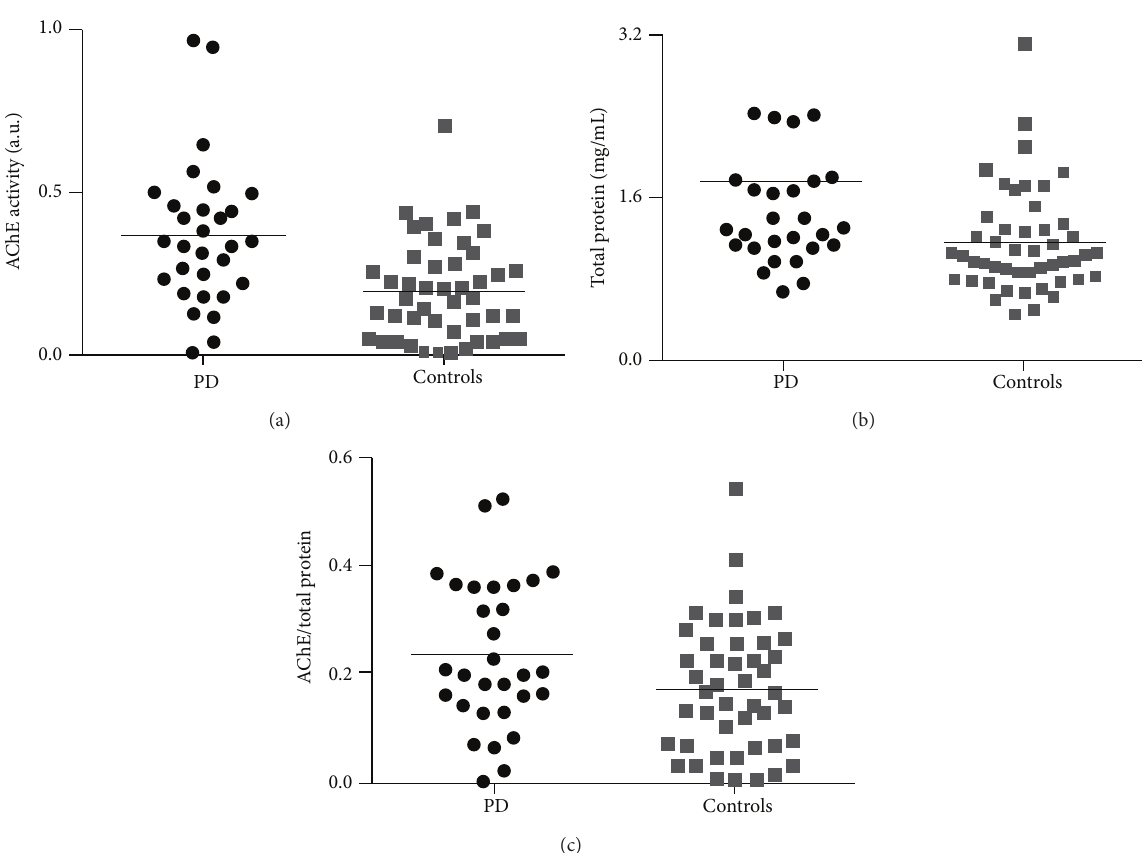
Figure 2: Salivary AChE activity (a), TP concentration (b), and AChE/TP ratio (c) in 30 PD patients and 49 control subjects. (Three TP outliers in the PD group not shown on graph).